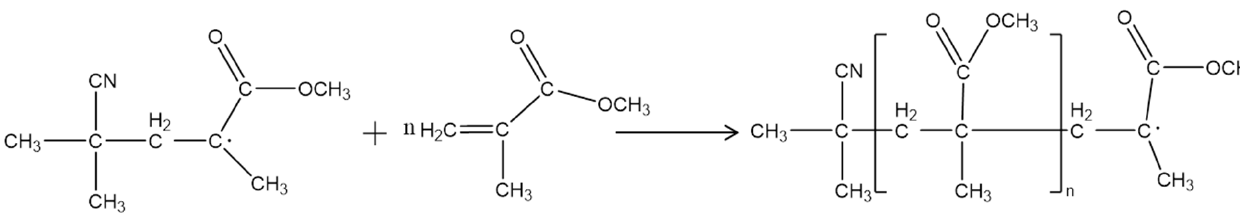
Figure 9. Monomeric radical chain additions form long-chain radicals.